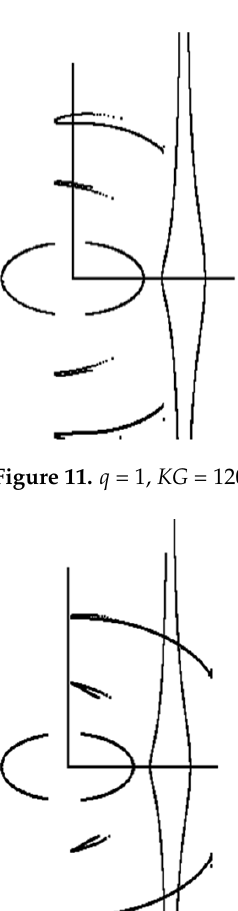
Figure 10. q = 1, KG = 120, and DK = 220.